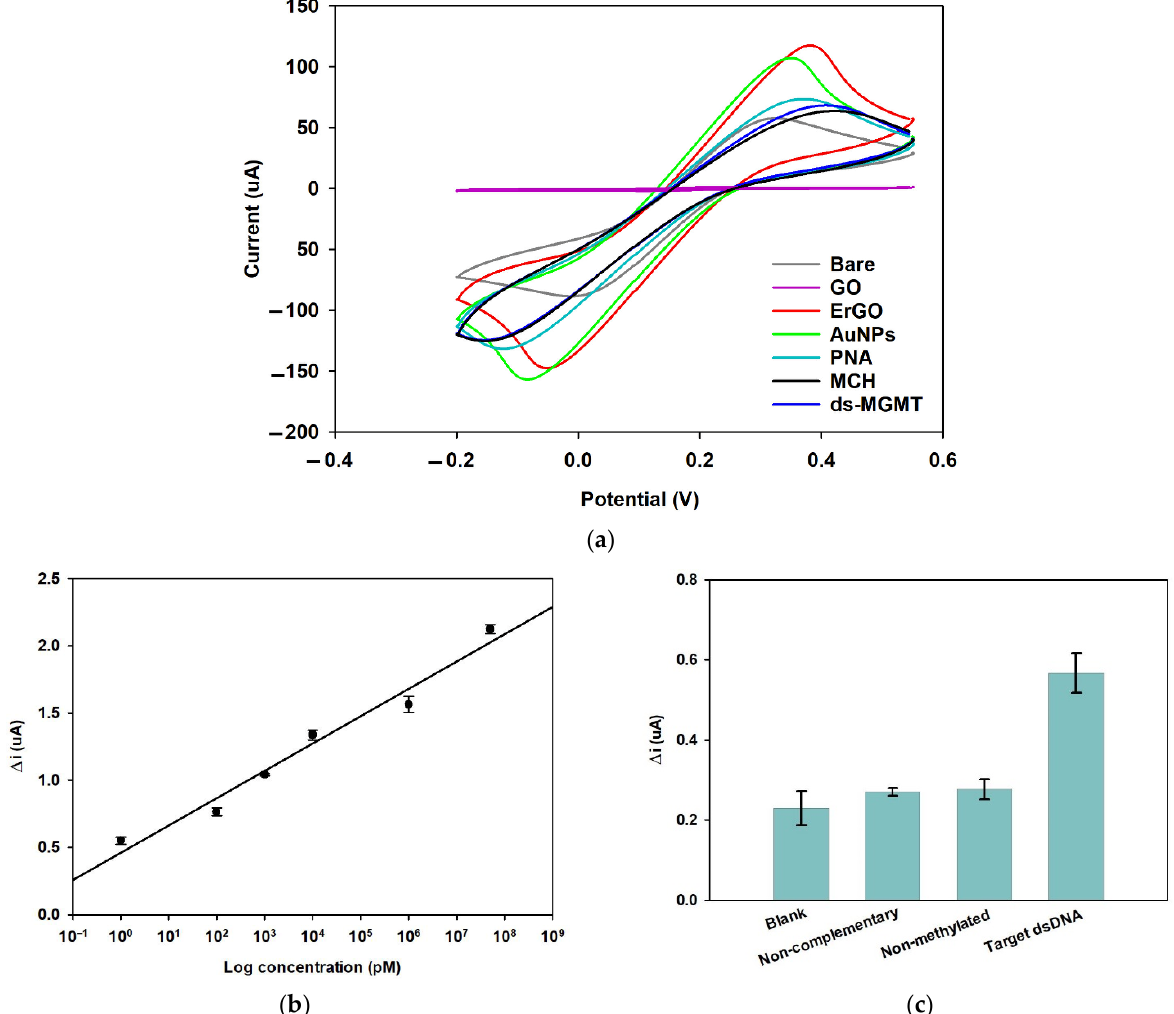
Figure 5. Comparison of CV voltammograms of the various preparation steps of the biosensor: Bare, GO, ErGO, AuNPs, PNA, MCH, and ds-MGMT ( a ). Linear regression studies for the ds-MGMT gene using the amperometric technique. Error bars are the standard deviation of at least three electrodes ( b ). Comparison of the amperometric response of the biosensor in different targets: blank (mouse plasma), the ss-MGMT gene, and the ds-MGMT gene spiked in mouse plasma ( c ).